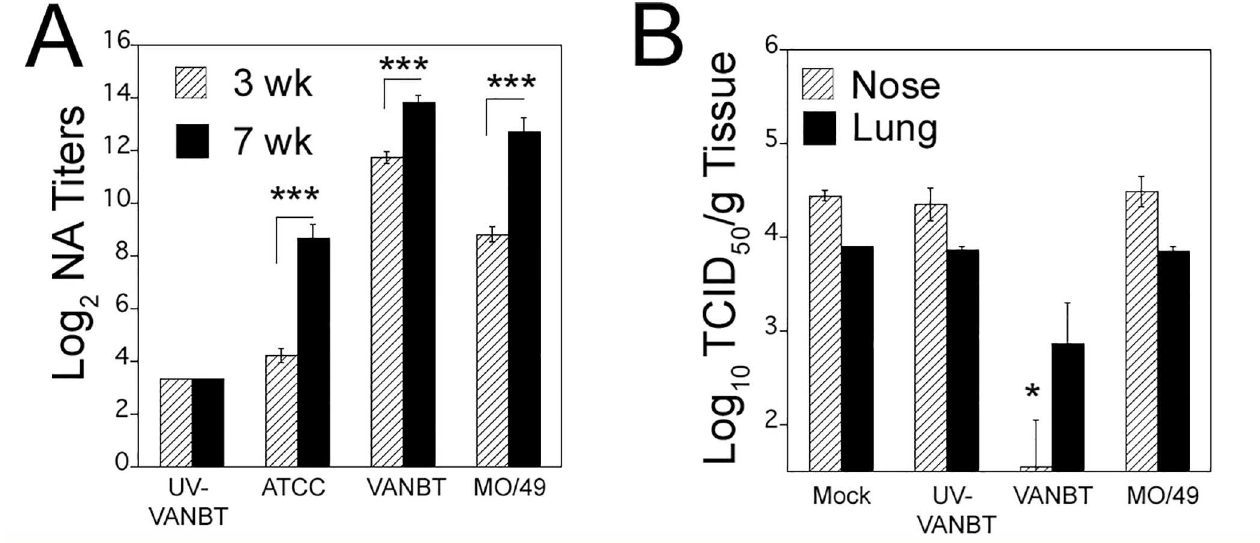
Fig 4. Intramuscular immunization with live EV-D68 strains induces virus-specific homologous NA titers. (A) Female cotton rats were immunized i.m. with 10 6 TCID 50 /100 μ l of indicatedvirus on day 0 and boosted 3 weeks after the first immunization. Serum samples were obtained at 3 week (before boosting) and 7 weeks after the first immunization and homologousserum NA titers were determined. The sera were assayed in duplicateand NA titer is expressed as Log 2 geometric mean ± SE. n = 10–15 from two independent experiments, *** p < 0.001 for 3 weeks NA titer compared with 7 weeks NA. (B) Passive transfer of VANBT immune sera protects animals from VANBT challenge.Animals were treated intraperitoneally with 0.5 ml 1 x PBS (mock) or serum from animals immunizedi.m. with either UV-VANBT, VANBT, or MO/49. The followingday, animals were challengedi.n. with 10 6 TCID 50 of VANBT and euthanized 10 h later to determine nose and lung viral titers. n = 4–5 per group. * p < 0.05 for each group compared with mock group.